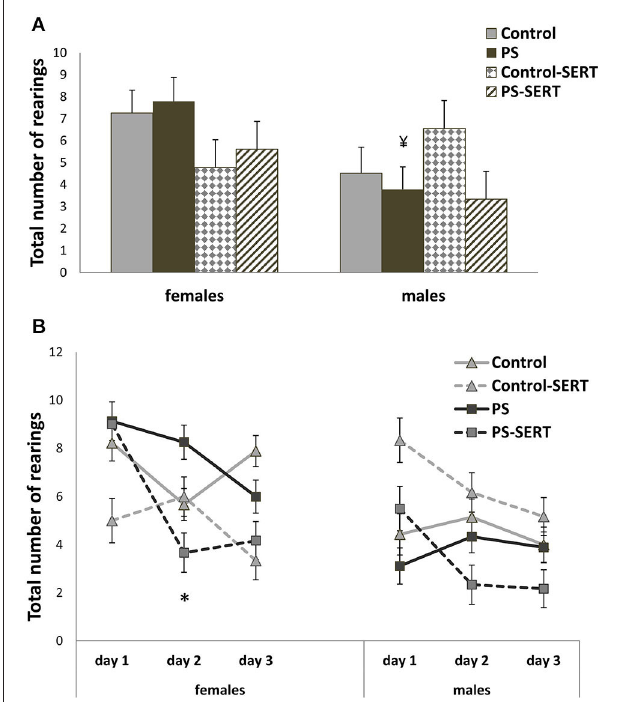
FIGURE 6 | Effects of prenatal stress and SERT treatment on the vertical activity in the OF test . Number of rearings observed during 3 min sessions on 3 consecutive days (Panels A and B ). Mean values ± standard error. No differences as effect of prenatal stress or SERT-treatment were found, F 3,69 = 0.58, p > 0.05. (cid:85) , p < 0.05 indicates a main effect of sex on PS animals. * p < 0.05, indicates a significant decrease from day 1 to day 2 of test, on the number of rearings in PS-SERT females.